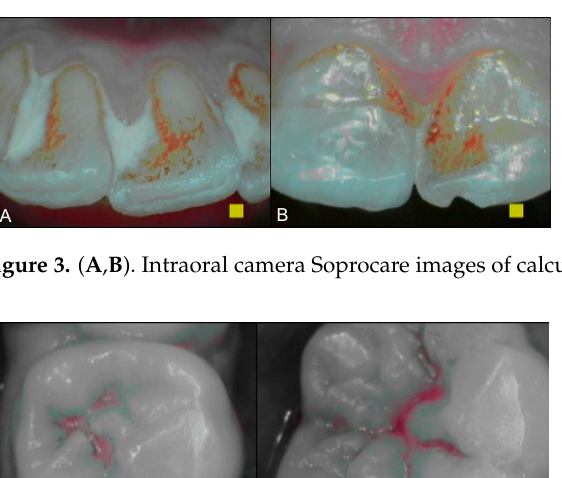
Figure 4. ( A , B ). Intraoral camera Soprocare images of active demineralization processes on the occlusal surface of the teeth.